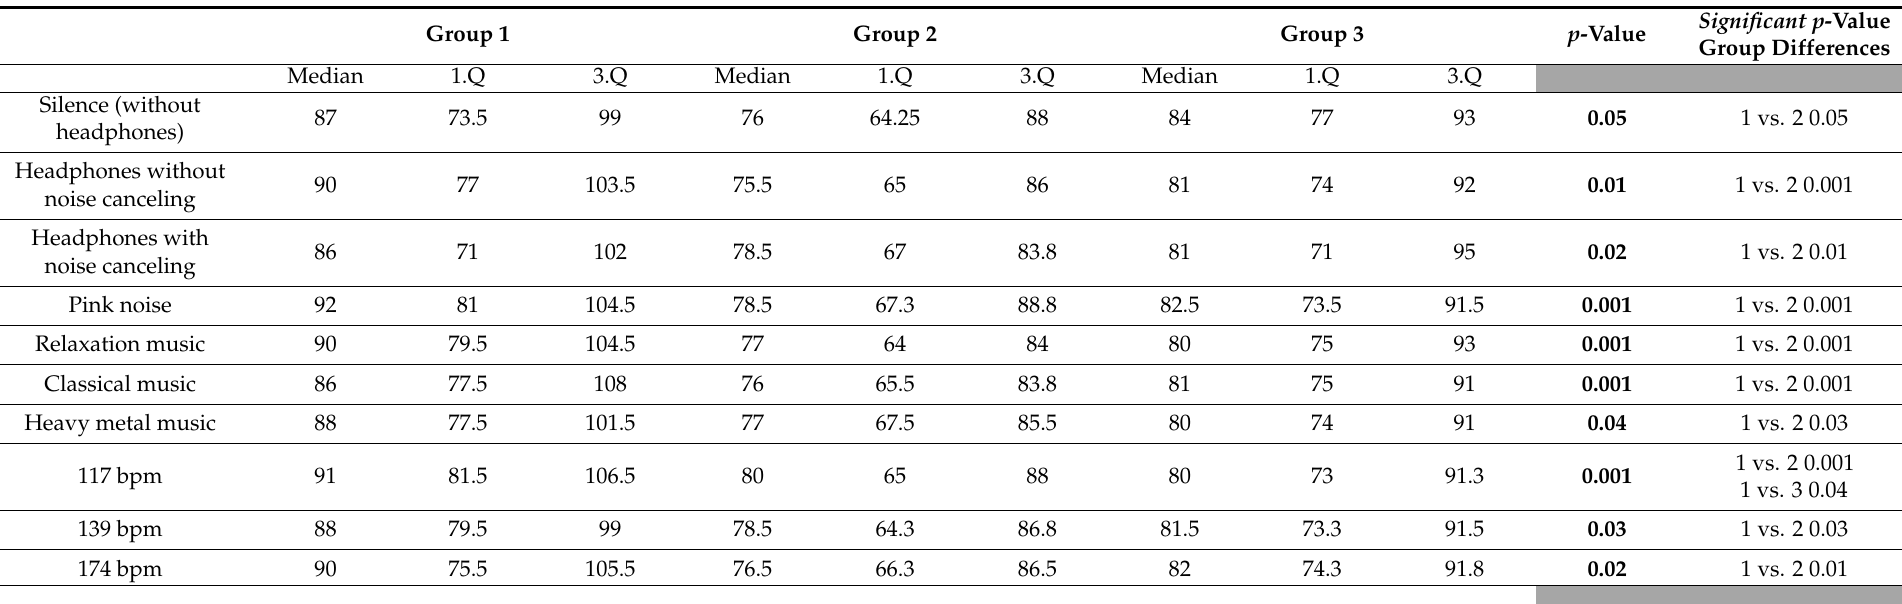
Table 2. Median, 1st and 3rd quartiles of each group for all measurement conditions. Between-group differences: p -values of the Kruskal-Wallis test for comparing the three groups per measurement condition with each other are given after each condition as well as the p -values of the Conover-Iman test (Bonferroni-Holm corrected) regarding the pairwise comparisons. Significant p -values are indicated in